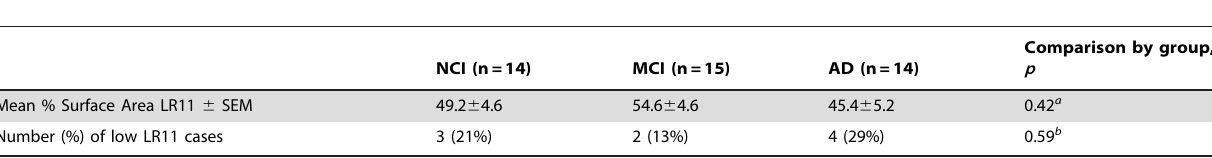
Table 2. LR11 Expression in frontal cortex is highly variable from case to case but comparable across clinical diagnostic groups.